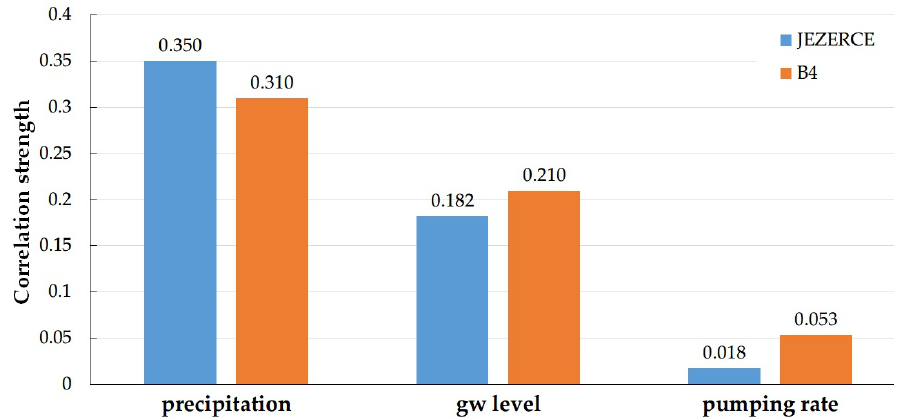
Figure 7. One input, one output simple analysis (SISO) analysis of the input data and enterococci (ENT) for wells B4 and Jezerce.